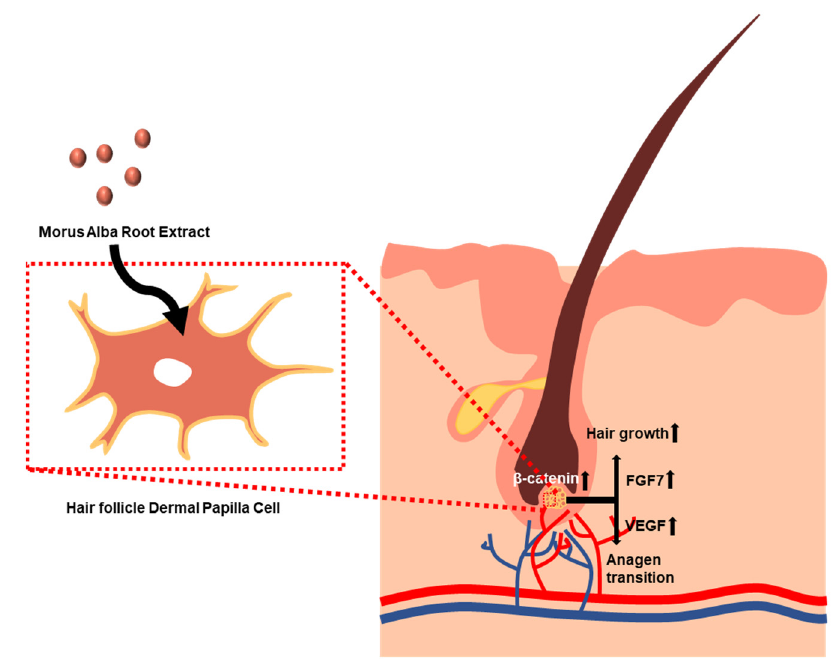
Figure 7. Illustration of the effects of MARE on the HFDPCs and hair growth-inducing potential.